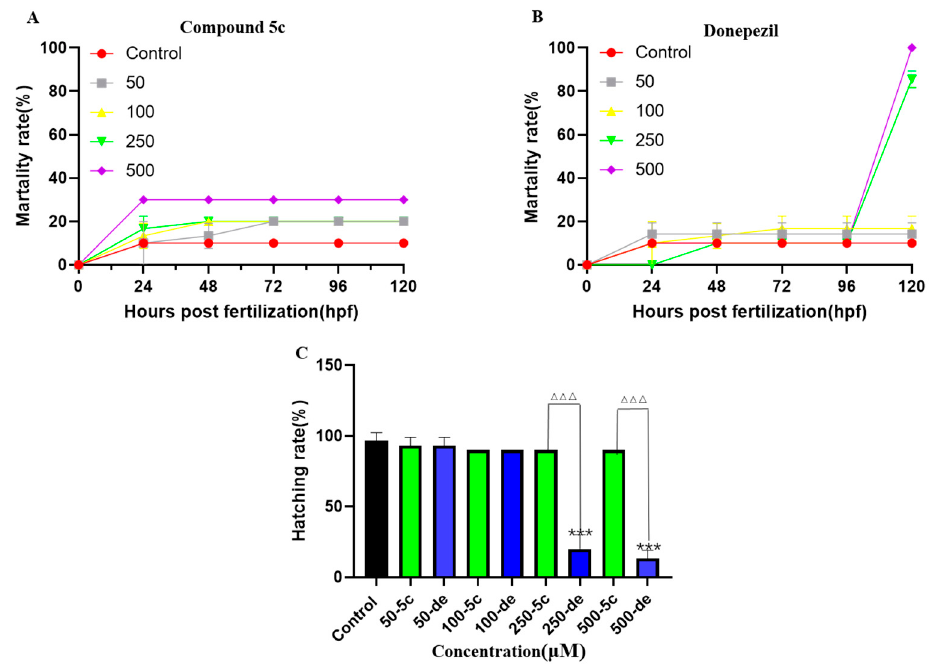
Figure 10. Effects of compound 5c and donepezil on zebrafish mortality and hatching rate at 4 hours post-fertilization (hpf). Zebrafish embryos were exposed to different concentrations of compound 5c and donepezil, and the mortality rate was recorded at 24, 48, 72, 96, and 120 hpf, respectively. The hatching rates were recorded for 120 hpf. ( A ) Effects of compound 5c on zebrafish mortality. ( B ) Effects of donepezil on zebrafish mortality. ( C ) Effects of compound 5c and donepezil on hatching rate. *** p < 0.001 vs. control group; △△△ p < 0.001 compound 5c group vs. donepezil group.